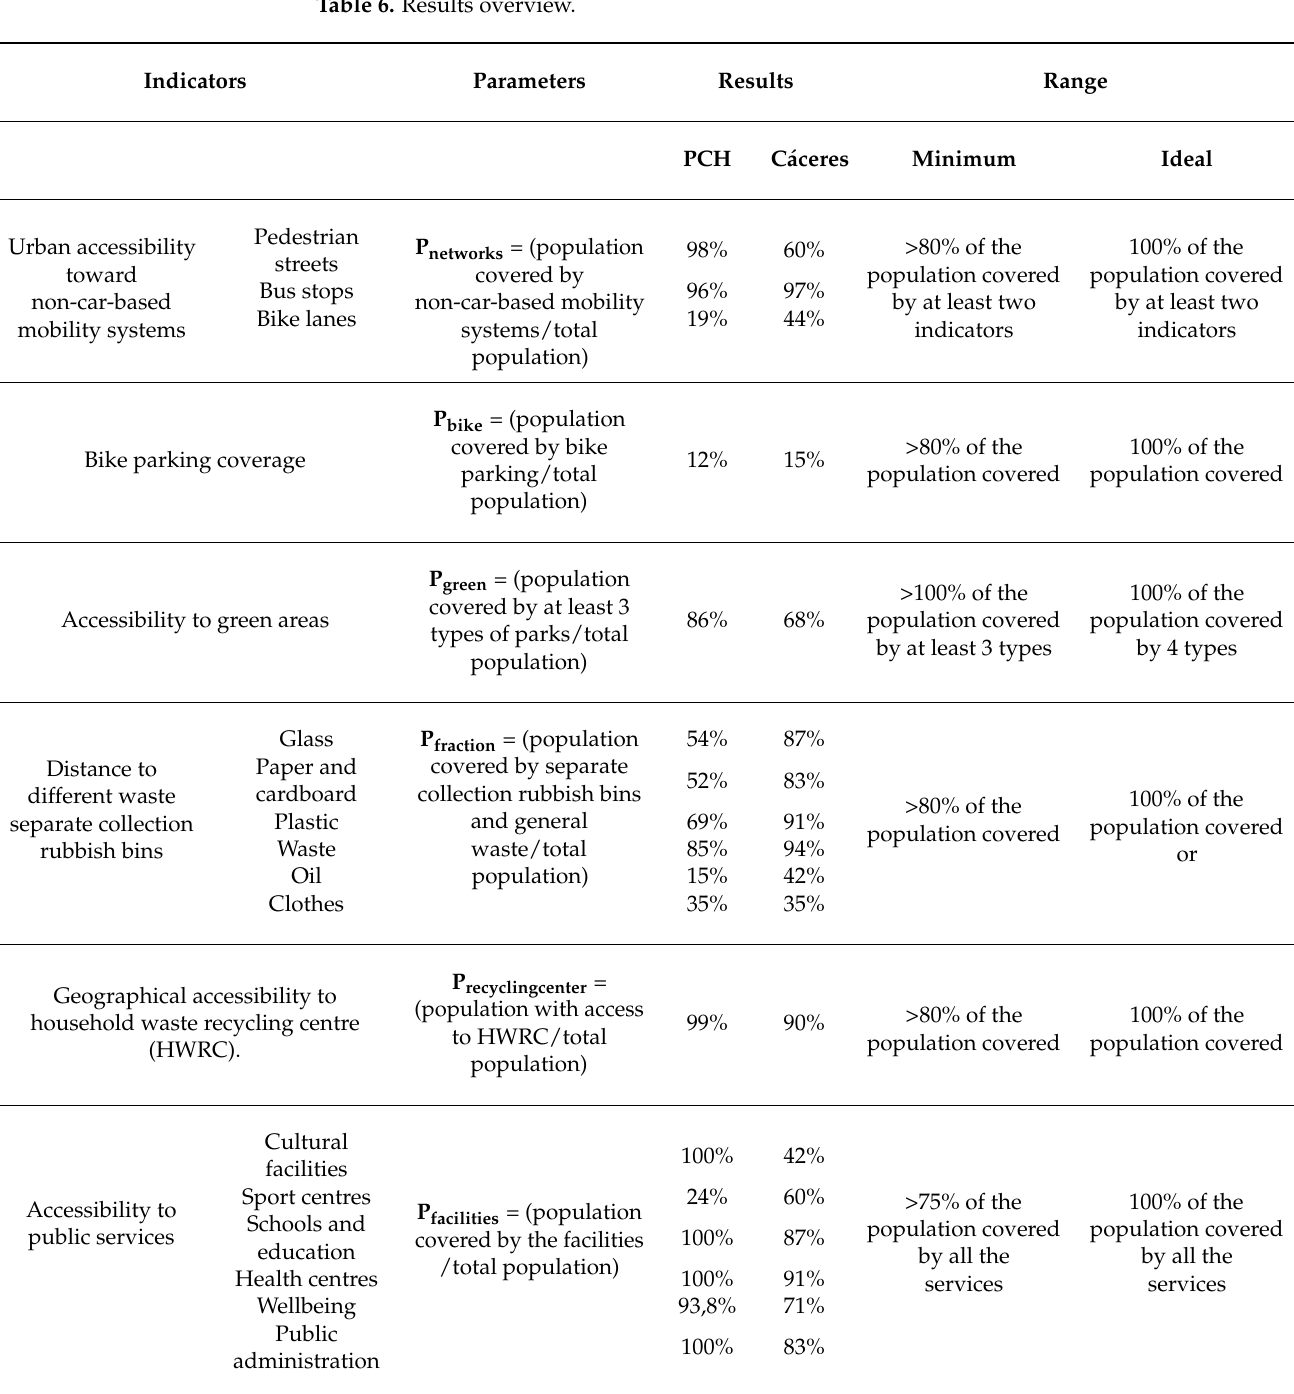
Table 6. Results